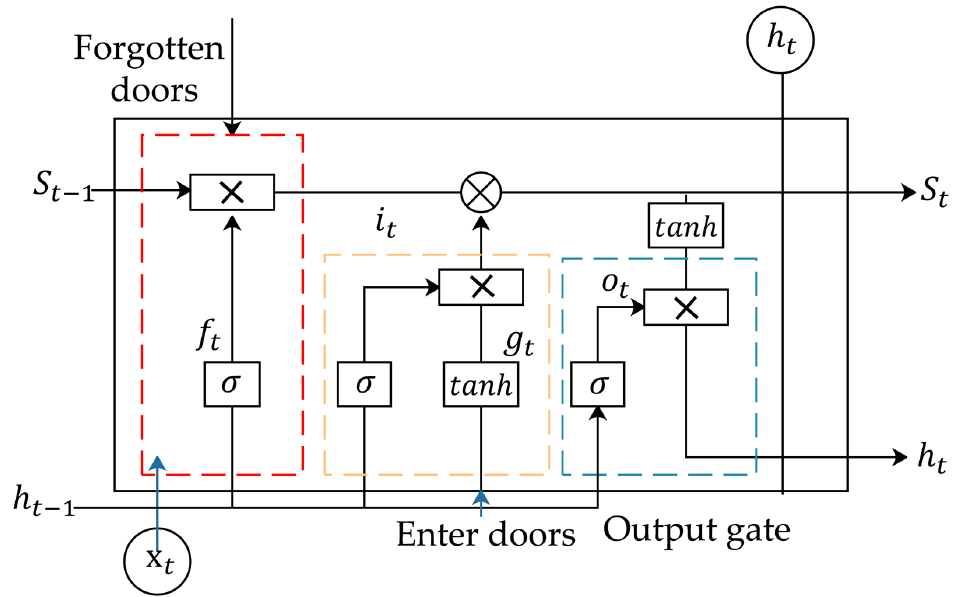
Figure 2. Structure diagram of LSTM neural network.